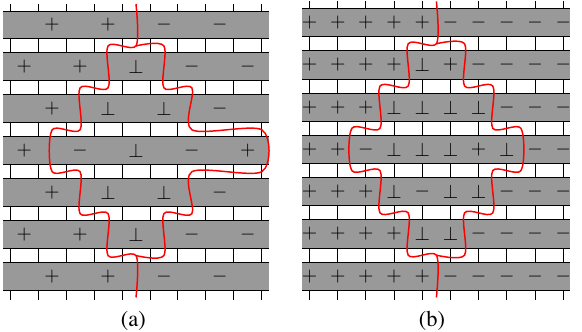
FIG. 15. Domain wall (membrane) in Floquet evolution with- out a circuit structure. The spin variables þ , − , and ⊥ denote the three choices of projection operators inserted on the horizontal bars beneath them; see Eqs. (102) and (103). Figures show samples of thick domain walls for (a) two-site and (b) one-site insertion.